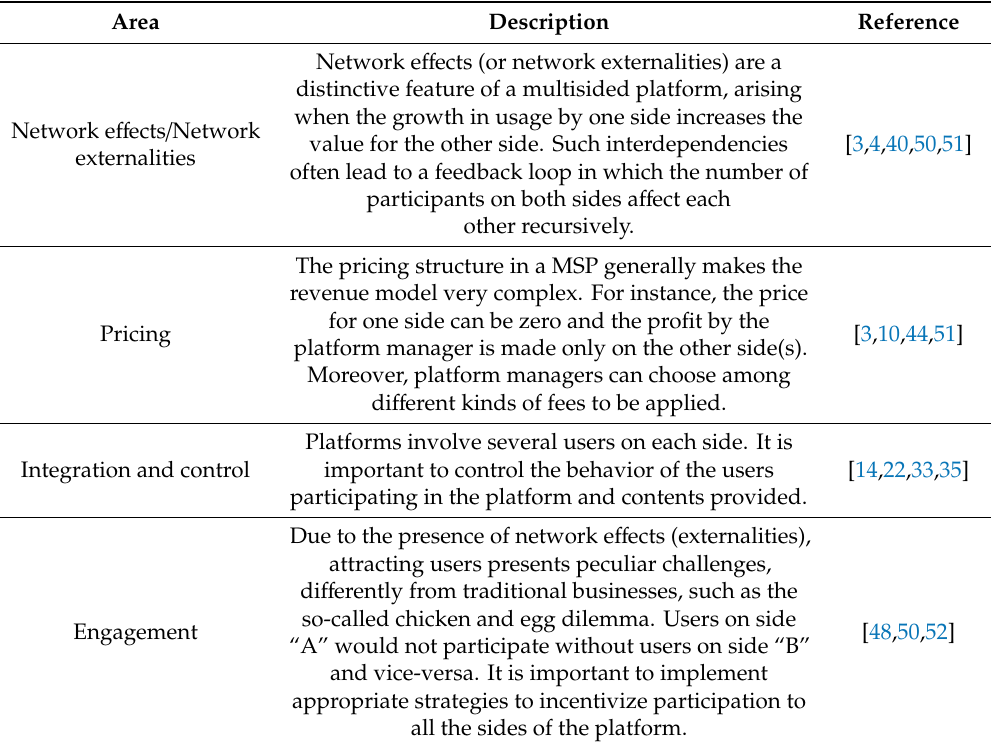
Table 2. Investigation areas about multisided